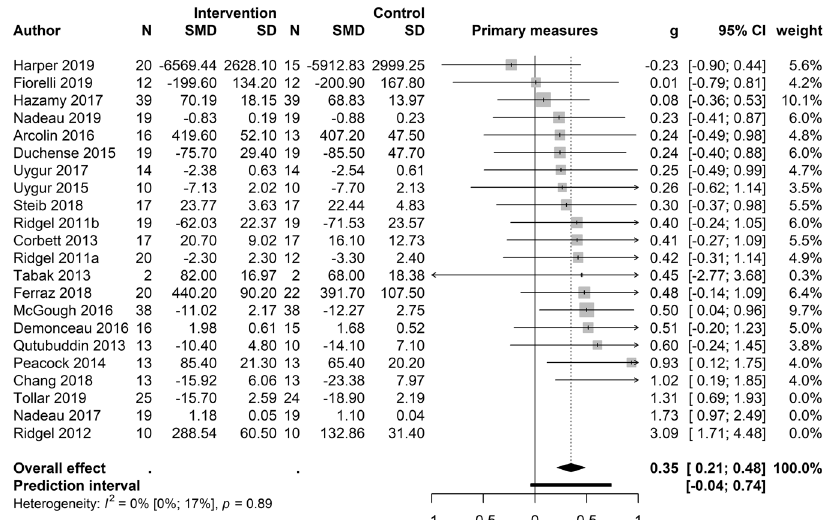
Fig. 3 Primary outcome measures. The forest plot demonstrates how each study contributes to the effect size of the primary outcomes. The overall effect is marked with the diamond symbol on x -axis of the effect size scale. N = Number of patients; SMD = standardized mean difference; SD = standard deviation; g = the Hedges ’ bias-corrected standardized mean difference, which was used to calculate the effect size; CI = 95% con fi dence interval; weight = the weight based on the inverse of the variance given to each study; I ² = percentage of